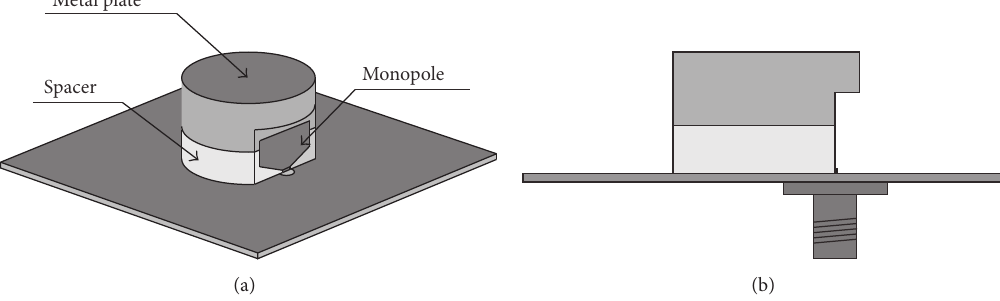
Figure 49: A dielectric resonator antenna excited by an electric probe having a trapezoidal shape [197]. Tridimensional view (a) and lateral view (b). The DR region with the notch is that where the strip-fed system used to excite the DRA is placed.